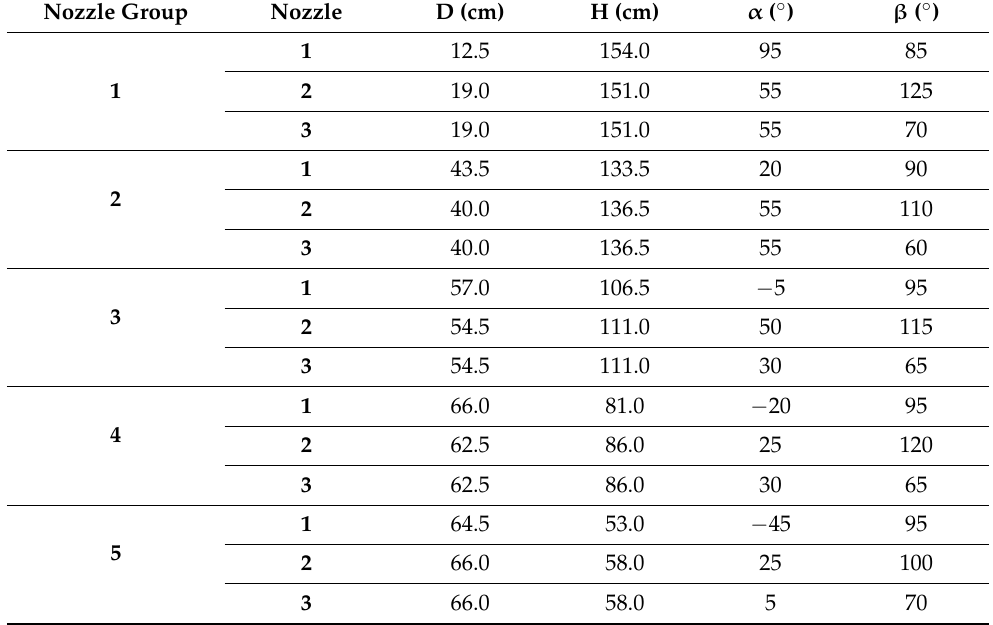
Figure 3. ( a ) Nozzles’ boom of the C sprayer (C1 and C2), and ( b ) of the T sprayer, with a detail of the circular triple nozzle holder. Table 3. Position and orientation of the air-assisted sprayer with a 1-boom triangular outlet deflector (T sprayer). D: distance of the nozzle from the central axis of the fan. H: height of the nozzle with respect to the ground. α : angle formed by the projection of the nozzle in the XZ plane. β : angle formed by the projection of the nozzle in the XY plane. Nozzle